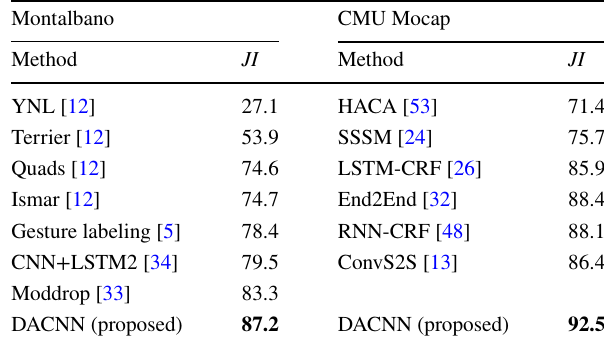
Table 1 Segmentation accuracy for Montalbano V2 and CMU Mocap based on Jaccard Index ( JI )